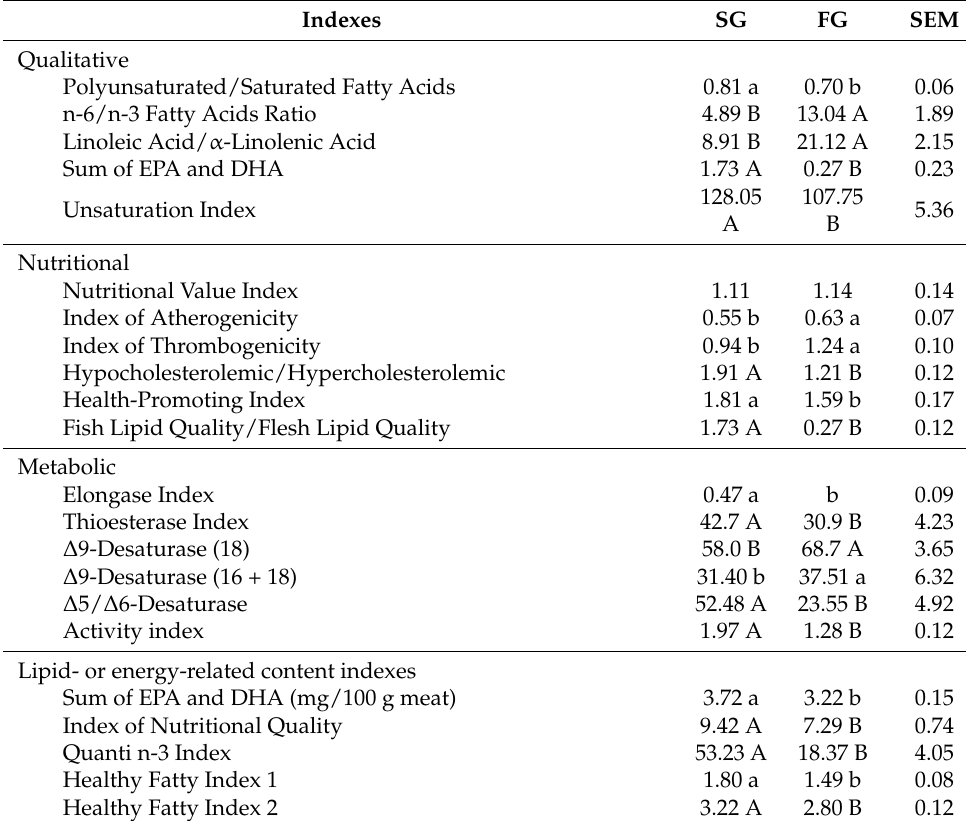
Table 4. Indexes of breast muscle of different chicken